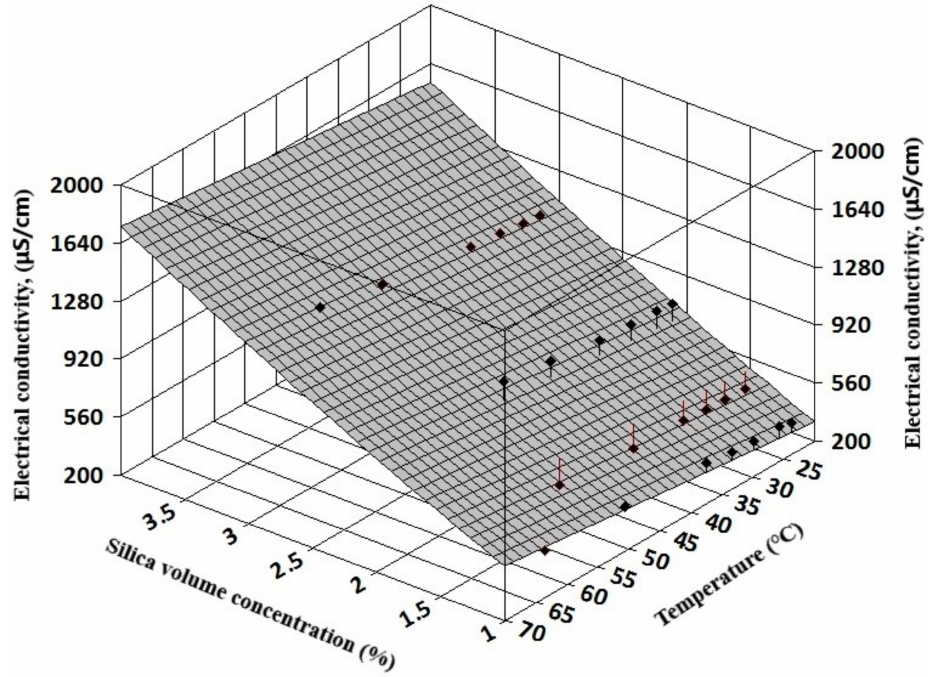
Figure 7. Three-dimensional analysis on silica nanofluids.